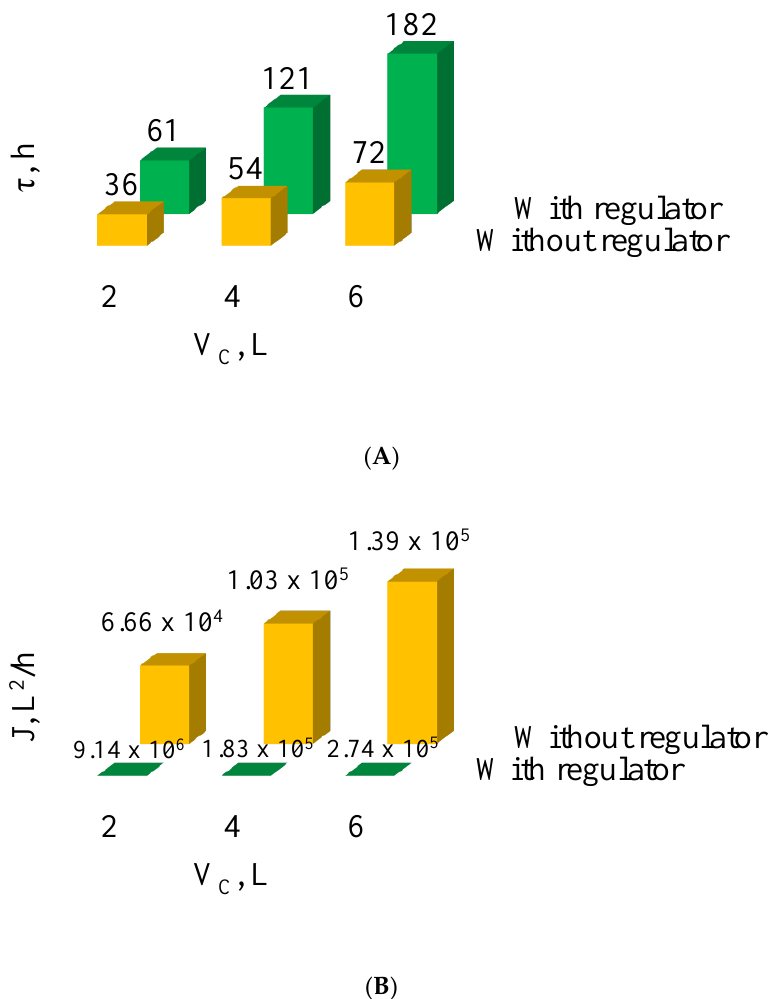
Figure 8. Comparison of the lubrication system with and without the regulator of the lubricant supply to inside the engine. ( A ) Comparison of the useful life of each load of lubricant and ( B ) Comparison of the performance index.